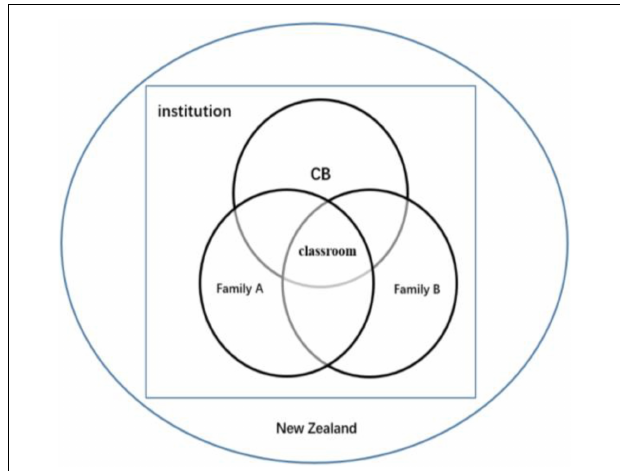
FIGURE 2 | The relationship between CB and other